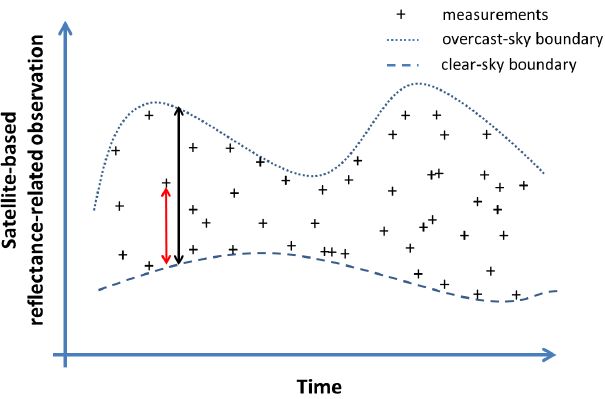
Figure 1. The calculation of a cloud index for a given location. The cloud index is the ratio between the distances “measurement to clear sky” (red arrow) and “overcast sky to clear sky” (black